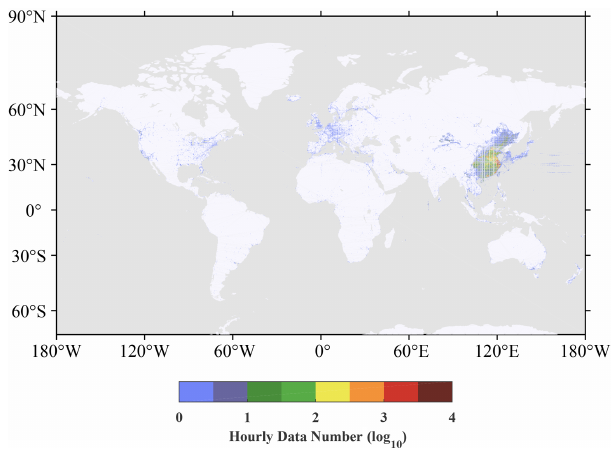
Figure 3. Hourly pressure observation counts (log10 transformed) averaged over the year 2016. Data are binned into a 0.1 ◦ × 0.1 ◦ grid.